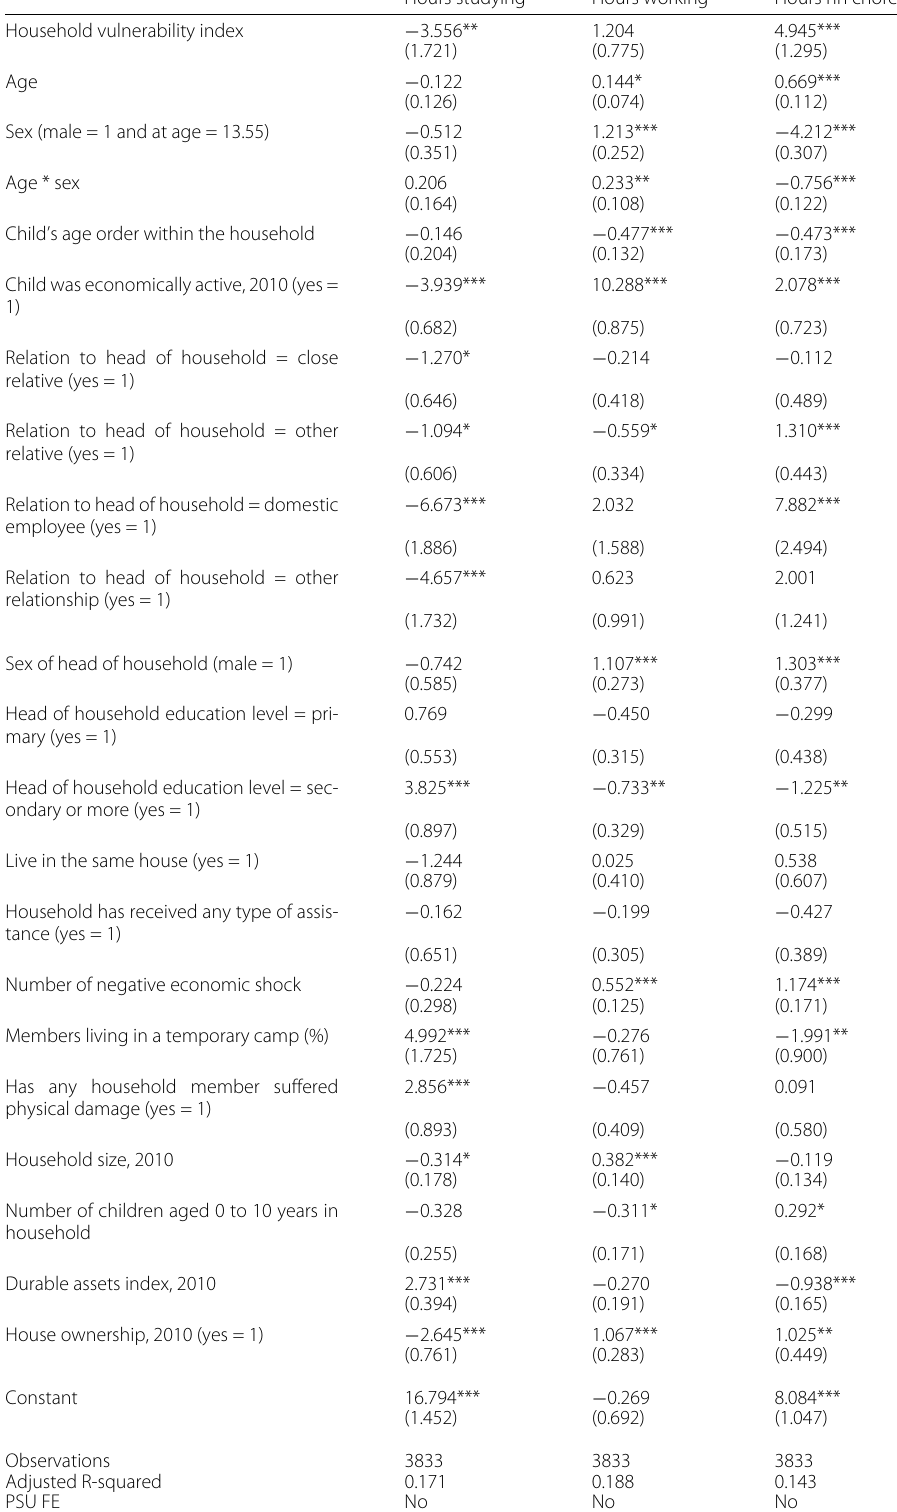
Table 10 OLS model without FE, number of